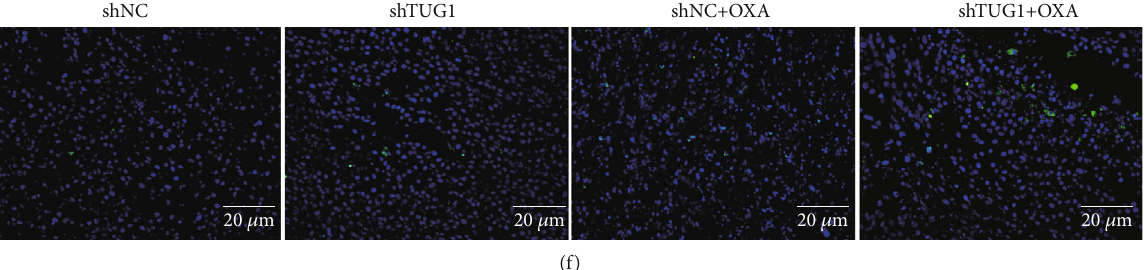
Figure 5: Regulation of lncRNA TUG1 on the CRC stem cell characteristics and chemoresistance in vivo . CD133 + /CD44 + isolated from HCT-116 cells transfected with Lv-shTUG1 were injected into mice to establish a xenograft model and the oxaliplatin (5 mg/kg) was injected into mice every three days, and 6 mice were randomly assigned to each group. (a) The tumor volume of mice was monitored ( n = 6 ). (b) Detection of the lncRNA TUG1 expression in tumor tissues by qRT-PCR. (c) Detection of the GATA6 mRNA level using qRT-PCR. (d) Analysis of the GATA6, BMP4, and BMP2 protein levels in tumor tissues by Western blot. (e) Detection of the protein levels of ALDH1 and Nanog using Western blot. (f) The cell apoptosis in tumor tissues was assessed by TUNEL assay (scale bar: 20 μ m). ∗∗ P < 0 : 01 and ∗∗∗ P < 0 : 001 vs. Lv-shNC; ### P < 0 : 01 vs. Lv-shNC+OXA. OXA: